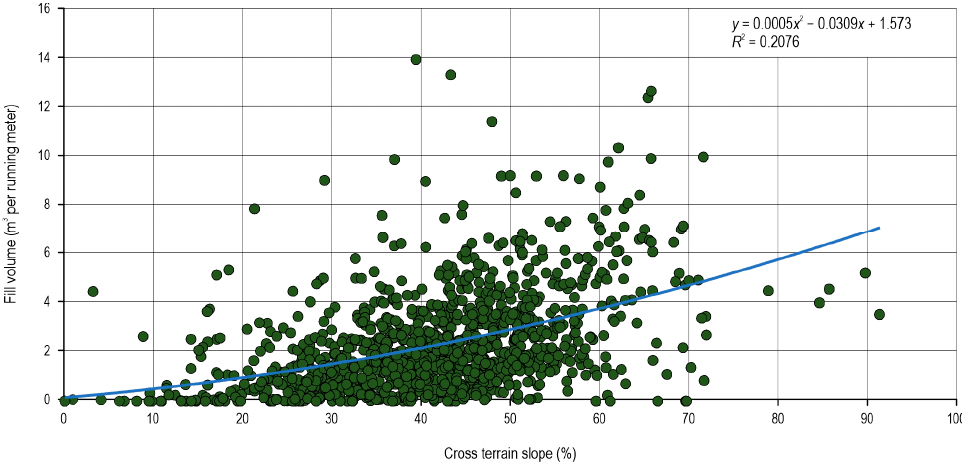
Figure 5. Impact of cross terrain on fill volume.